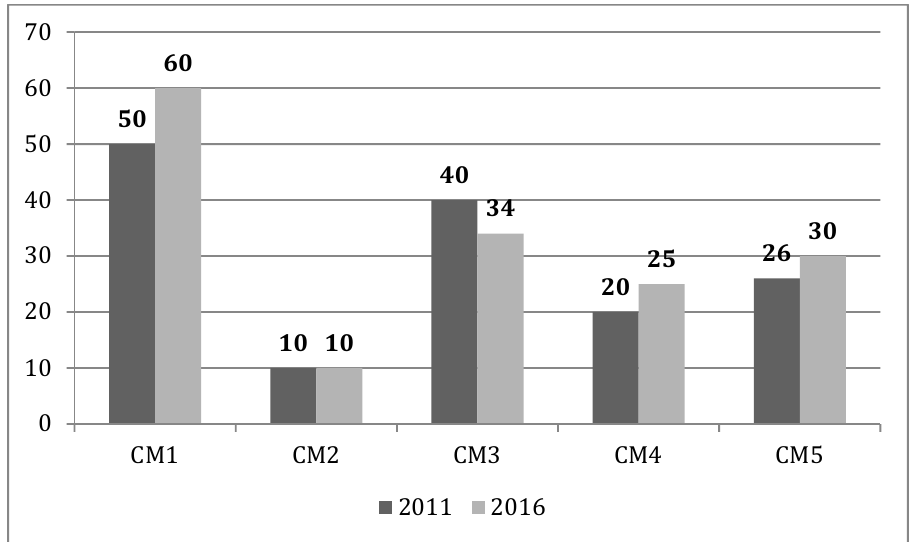
Figure 5. The results of the assessment of natural hazard in 2011 and 2016 in the examined hard coal mines. Source: own work.